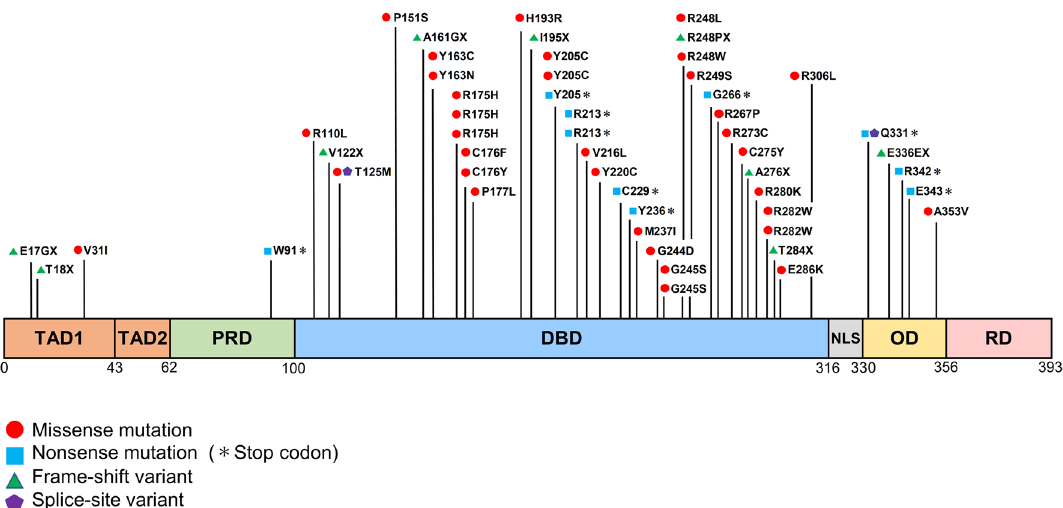
Figure 3. p53 mutational landscape in oral squamous cell carcinoma (OSCC). The distribution of p53 mutations was diverse, but many were present in the DNA-binding domain (DBD) (43/52) and these were mainly missense mutations (31/43). A truncation mutation of the DBD was found in 13/43 cases. In other regions (transactivation domain: TAD, proline-rich domain: PRD, oligomerization domain: OD) most mutations were truncation mutations (7/9), with missense mutation found in only 2